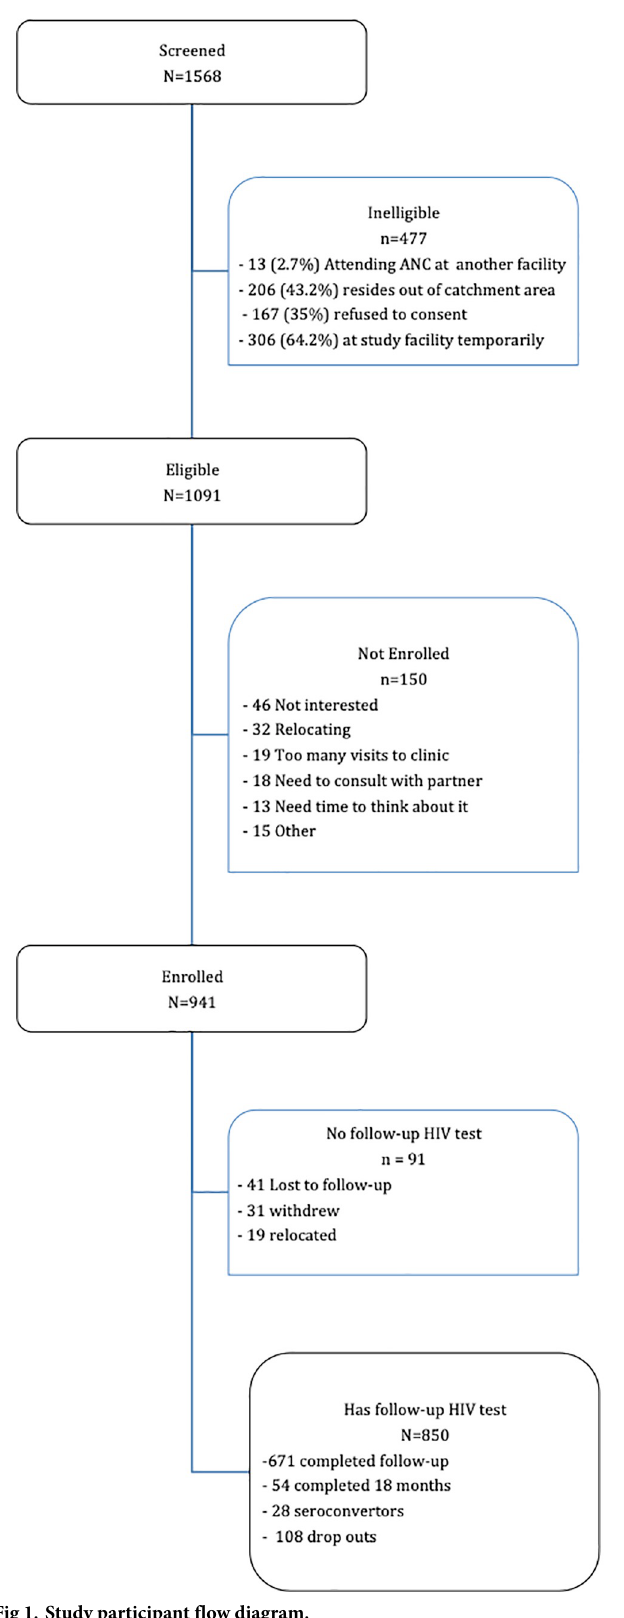
Fig 1. Study participant flow